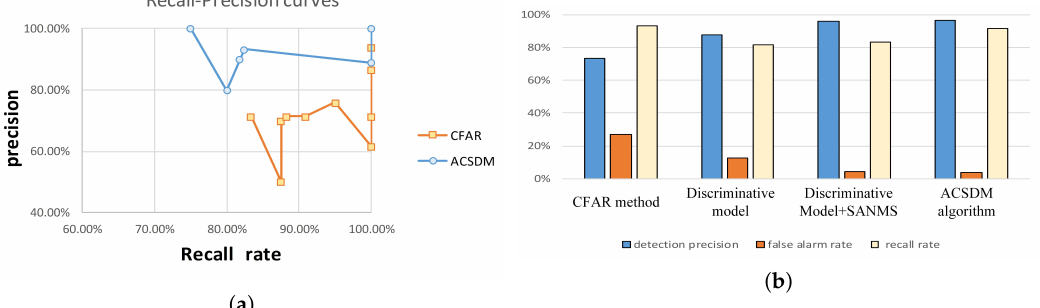
Figure 9. Different measurement indexes. ( a ) Recall–precision curves; ( b ) Accuracies of different detection